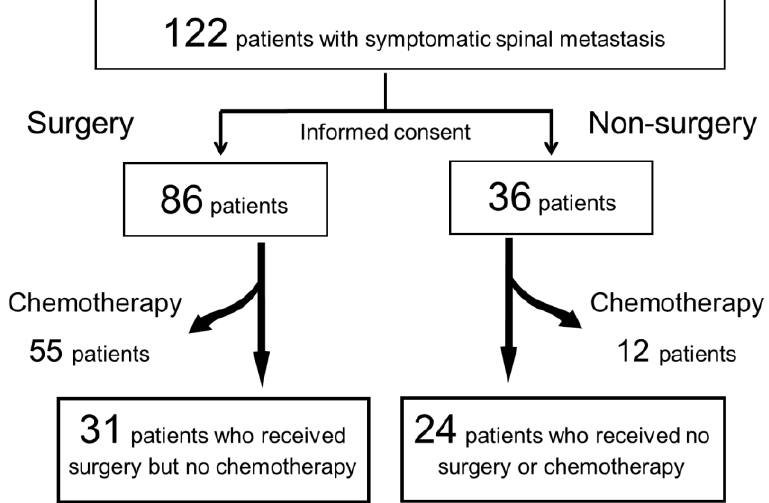
Figure 1. Flowchart of the study design.